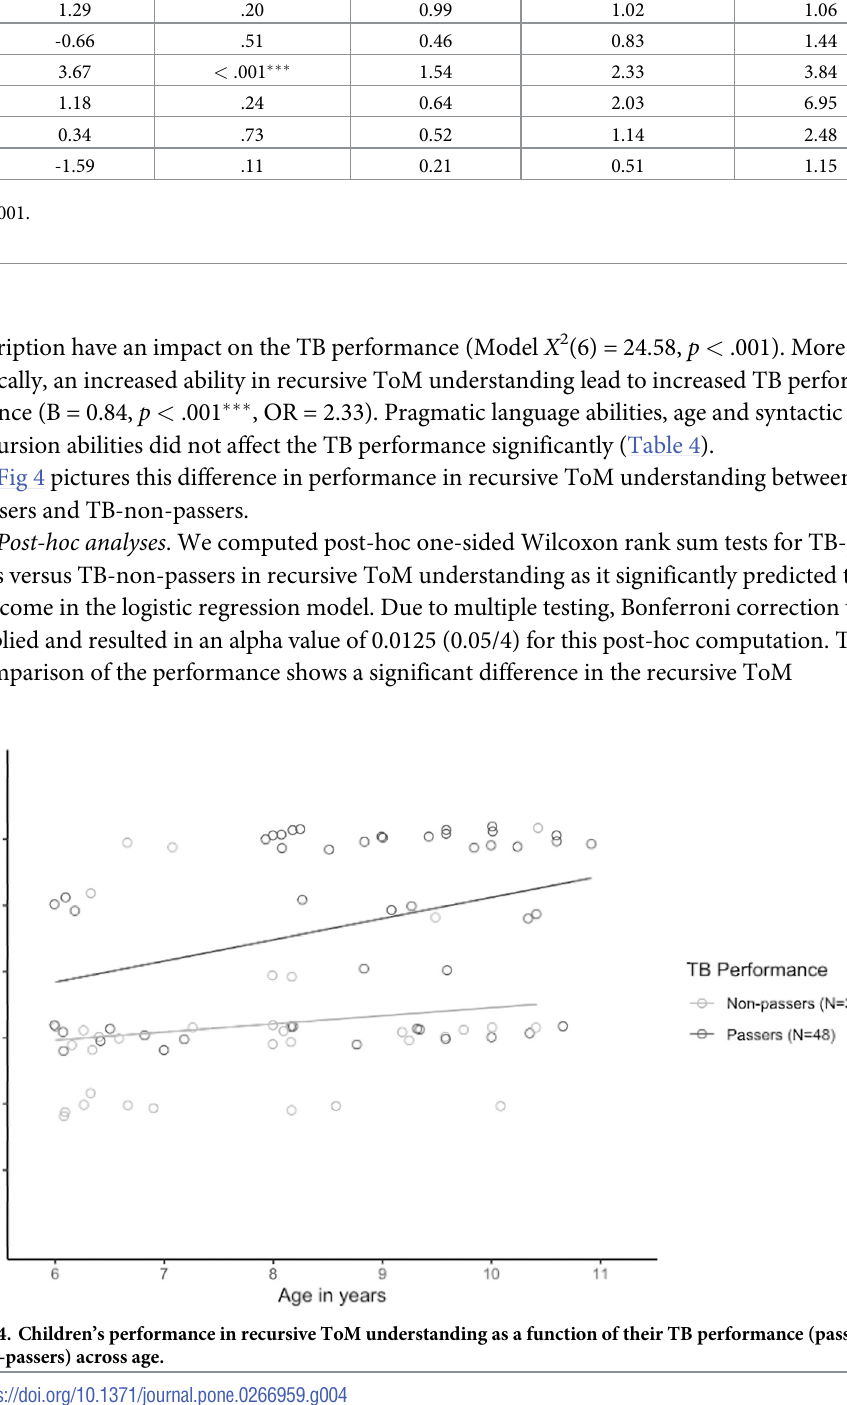
Fig 4. Children’s performance in recursive ToM understanding as a function of their TB performance (passers vs. non-passers) across age.